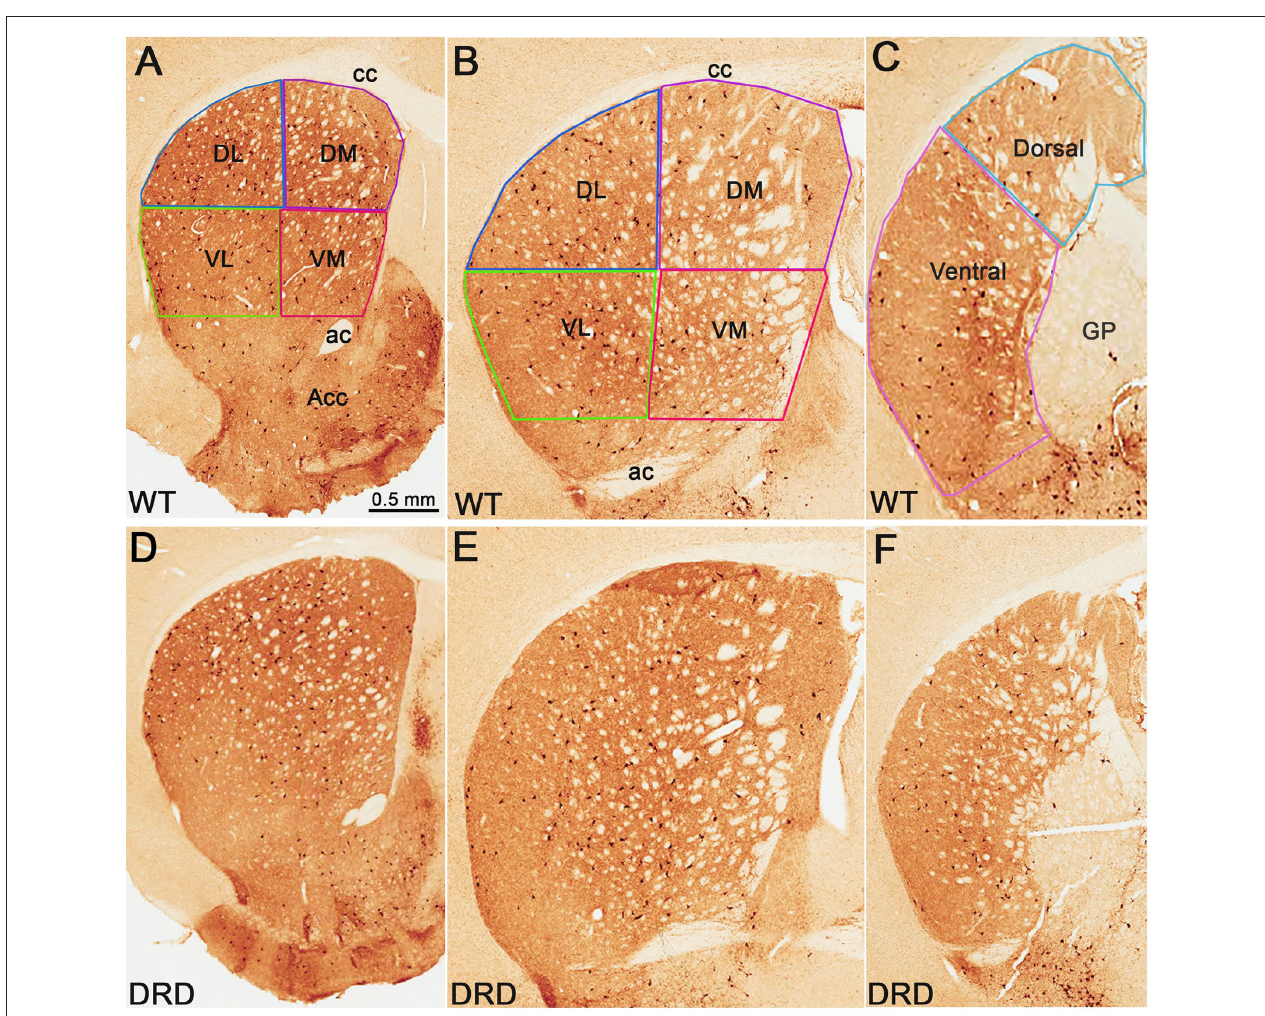
FIGURE 1 | (A–F) Low power views of choline acetyltransferase (ChAT)-immunostained sections from wild-type (WT). (A–C) and dopamine-responsive dystonia (DRD) (D–F) mice at the rostral (A,D) , middle (B,E) and post-commissural (C,F) striatal levels. In the top row, the regions of interest in the dorsal striatum (DS) from which data were collected, are delineated. Abbreviations: ac, anterior commissure; acc, nucleus accumbens; cc, corpus callosum; DL, dorsolateral; DM, dorsomedial; GP, globus pallidus; VL, ventrolateral; VM, ventromedial. Scale bar in (A) valid for (B–F)